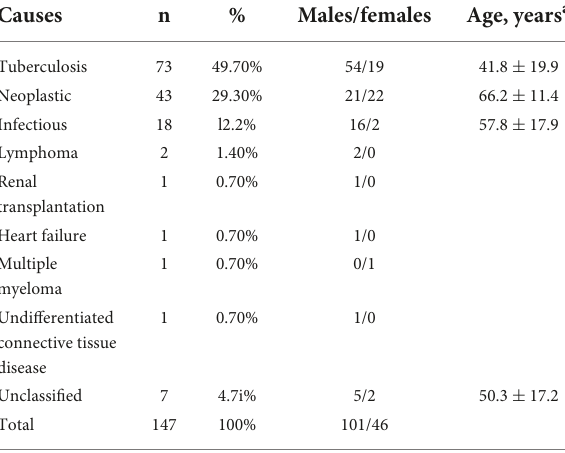
TABLE 1 The features at diagnosis of PE. TABLE 2 The whole features utilized in this research and